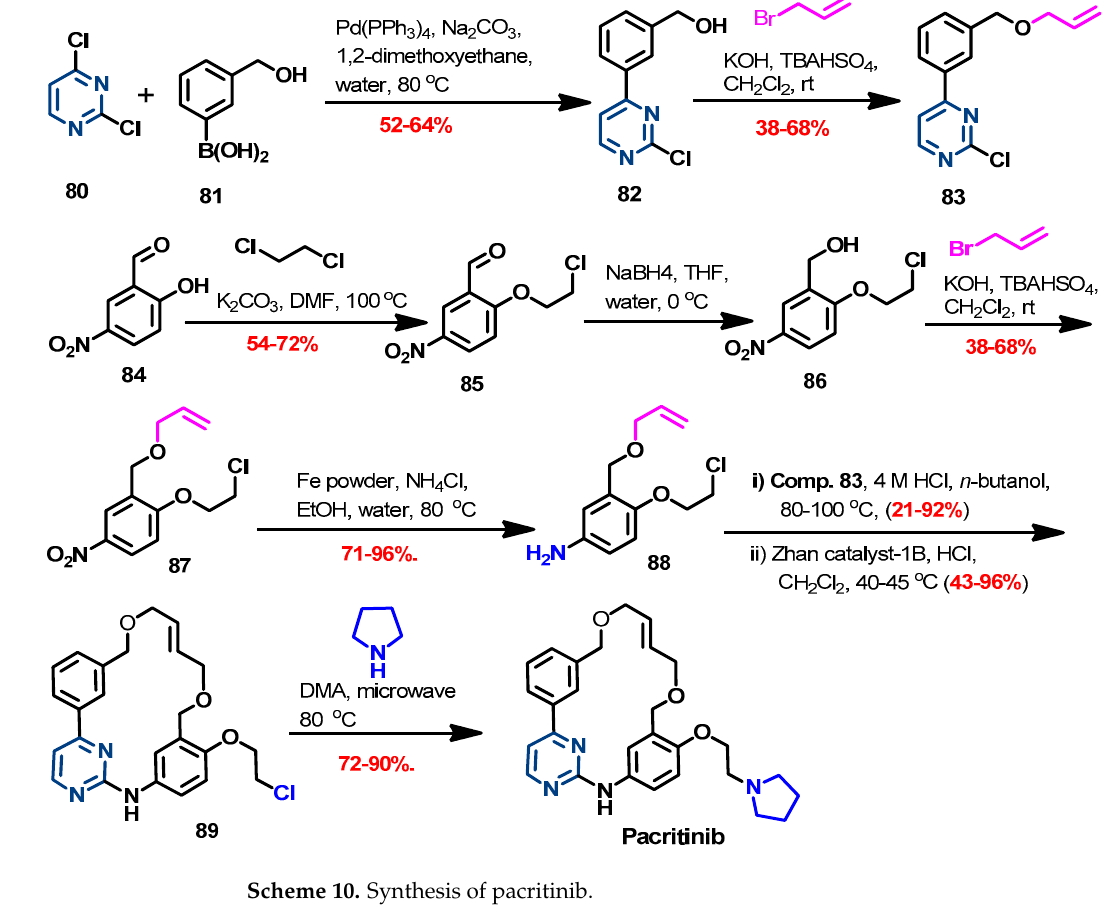
Figure 39. Chemical structure, name, and synonyms of pacritinib.